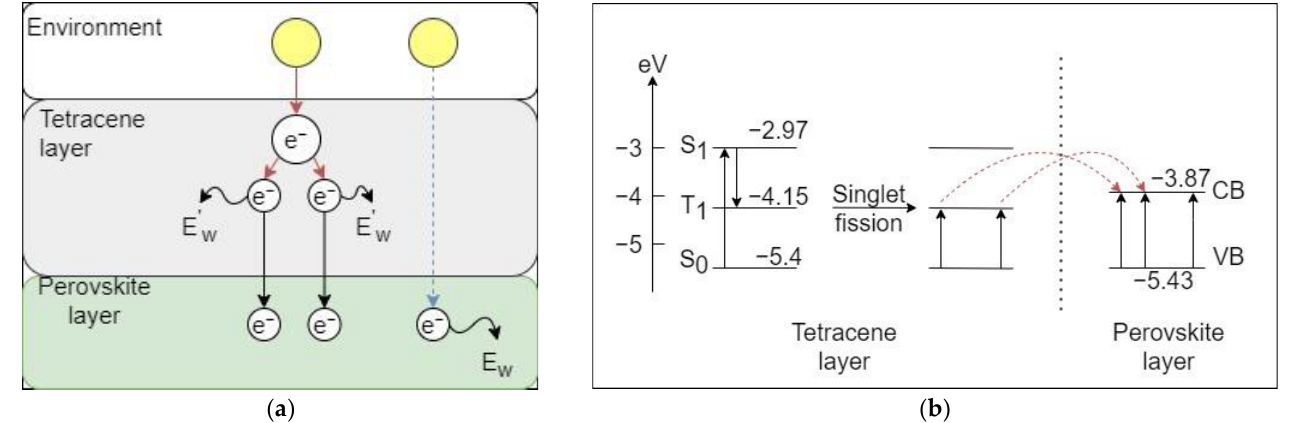
Figure 3. ( a ) Pathways of photons into electrons in the experimental case ( b ) Jablonski diagram for singlet fission in the experimental